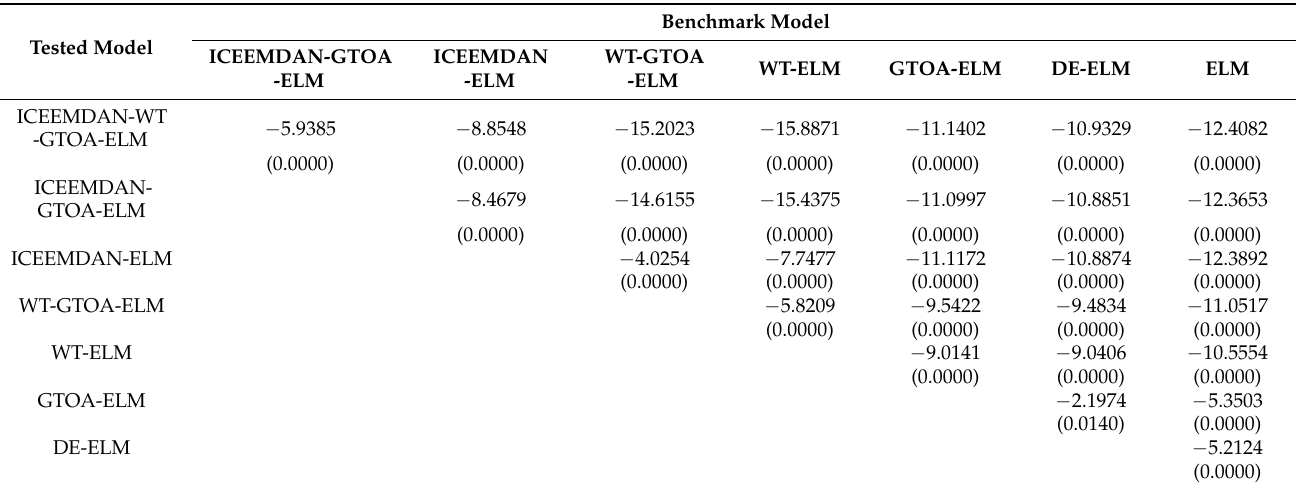
Table 7. DM test results of three-step ahead forecasting of